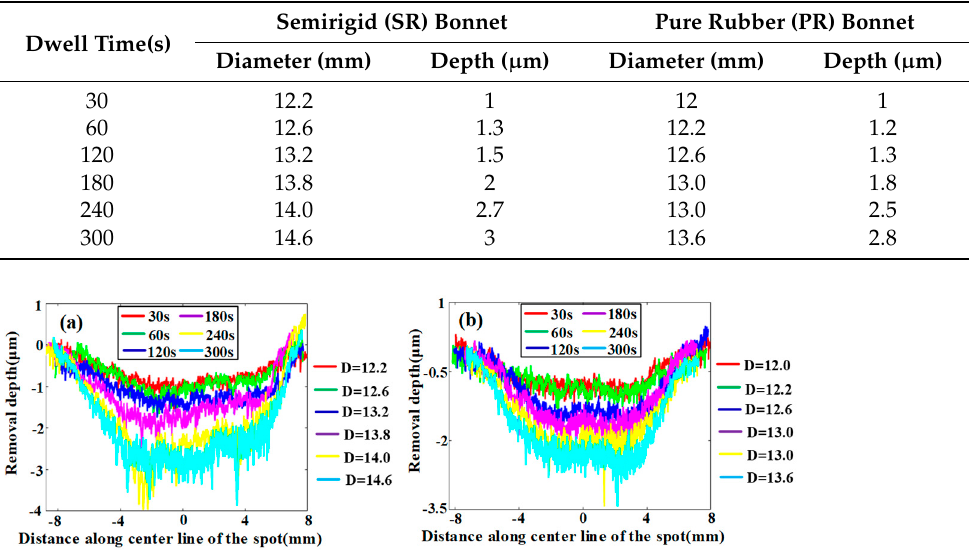
Figure 6. Section size of polishing point of ( a ) SR bonnet and ( b ) PR bonnet (D signifies the diameter of the spot).